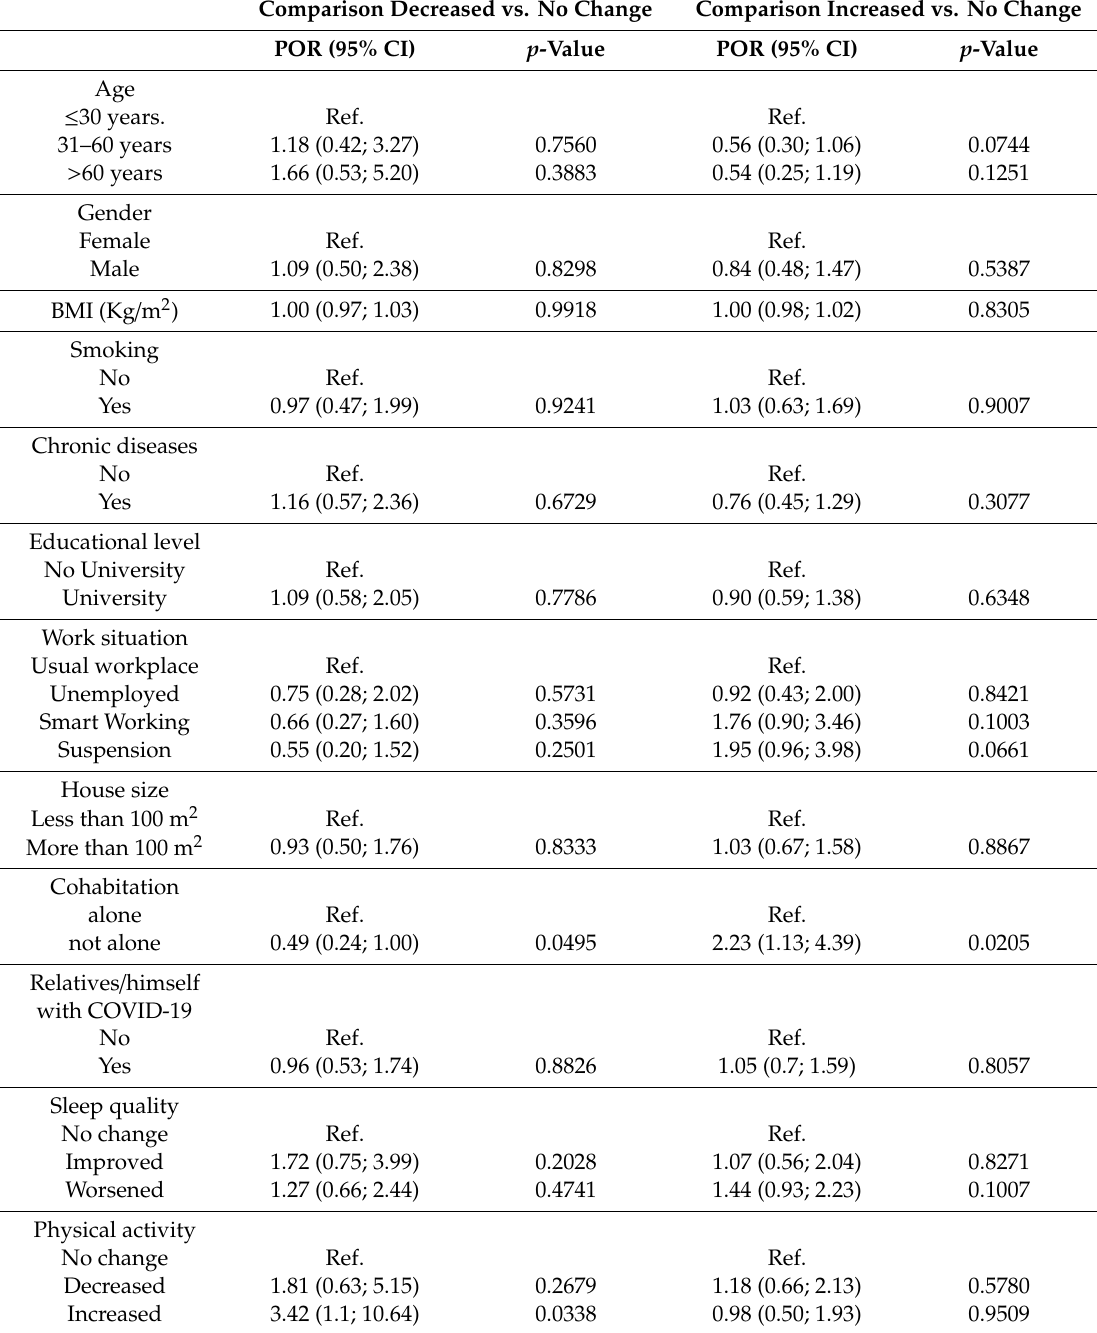
Table 4. Prevalence Odds Ratio (POR) for changes in food intake. Comparison Decreased vs. No